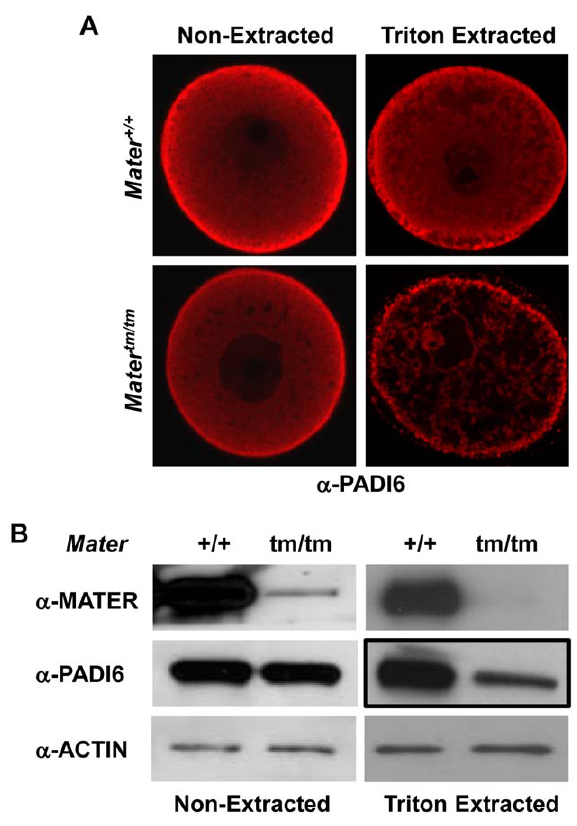
Figure 2. PADI6 Triton X-100 solubility is increased in Mater tm/tm GV-stage oocytes. ( A ) Confocal analysis shows Mater + / + and Mater tm/tm GV-stage oocytes prior to, and following, extraction with 0.1% Triton X-100. Oocytes were incubated with PADI6 antibodies (red). ( B ) Western blotting shows expression of MATER and PADI6 protein in Mater + / + and Mater tm/tm GV-stage oocytes prior to, and following, 0.1% Triton X-100 extraction. Isolated oocytes were either extracted or not extracted with Triton, and then evaluated by Western blotting using either anti-MATER, anti-PADI6, or anti- b actin antibodies.